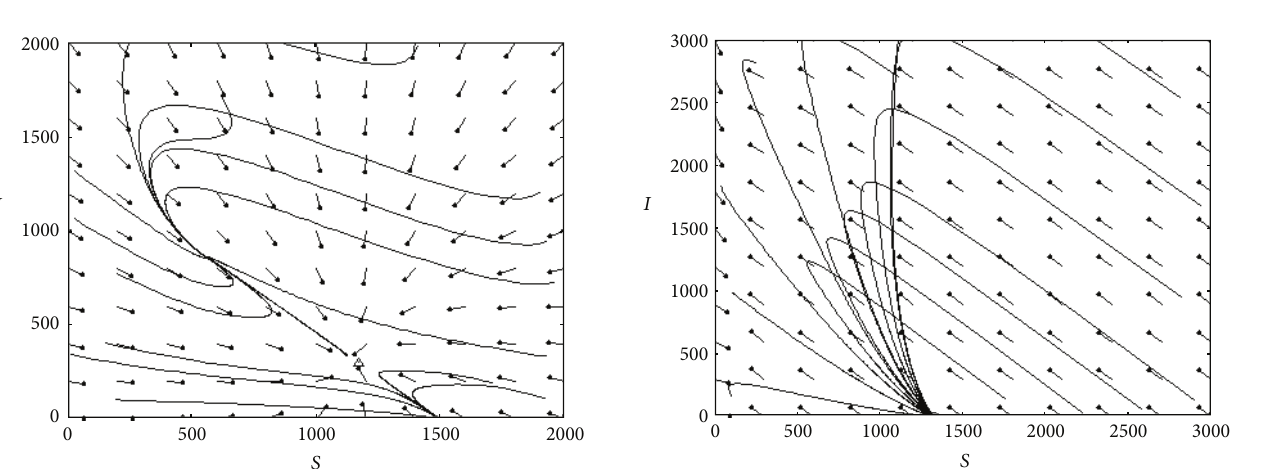
Figure 1: Phase plot of 𝐼 verses 𝑆 showing bistability when 𝑅 < 𝑅 0 < 1 and 𝛿 > 1 for the parameter values 𝑏 = 0.16 , 𝛾 = 0.015 , 𝜆 0.08 , 𝜇 1